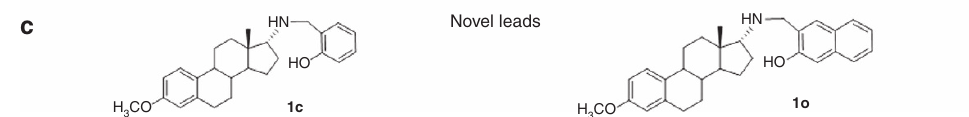
Figure 5 | Working hypothesis for the mode of action and optimization of R. ( a ) Ortho -hydroxylated arylmethyl amines exhibit the highest antimalarial activity. A chelate involving quinone methide mechanism is substantiated via structure/activity considerations. Both the redox pair phenol/quinone and the highly reactive quinone methide itself may be causative for biological activity. ( b , c ) The steroid core also plays a crucial role. The highest activity is found for estratriene